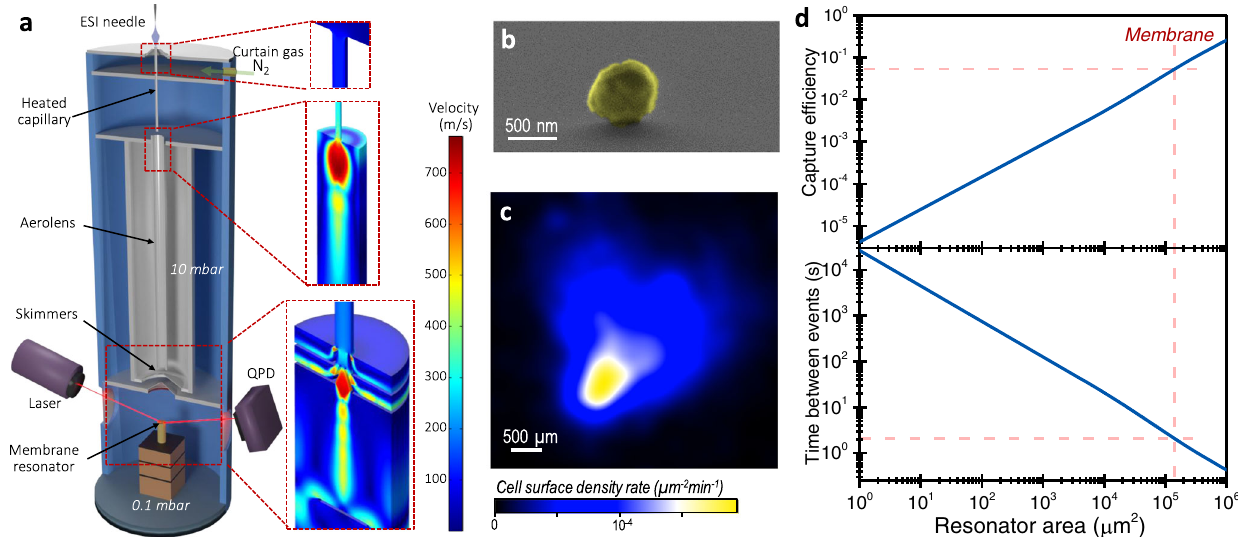
Fig. 1 Design of the nanomechanical spectrometer for characterization of the dry mass of bacteria. a Schematics of the instrument (left) and estimation of the absolute fl ow speed calculated by FEM (right). The bacterial cells approximately follow the fl ow lines. b Scanning electron microscopy image of a S. epidermidis cell on a silicon surface at the detector position after nebulization. c Cell surface density at the detector position surface per unit time for a nebulization of S. epidermidis . The cell surface density is characterized by dark- fi eld optical microscopy and subsequent digital counting of cell scattering spots. d Estimation of capture ef fi ciency (top) and mean time between adsorption events (bottom) as a function of the detector area. The data are calculated by integrating the cell surface density rate ( c ) over a rectangle region that maximizes the number of collected cells. The dashed redlines mark the data for the membrane used in this